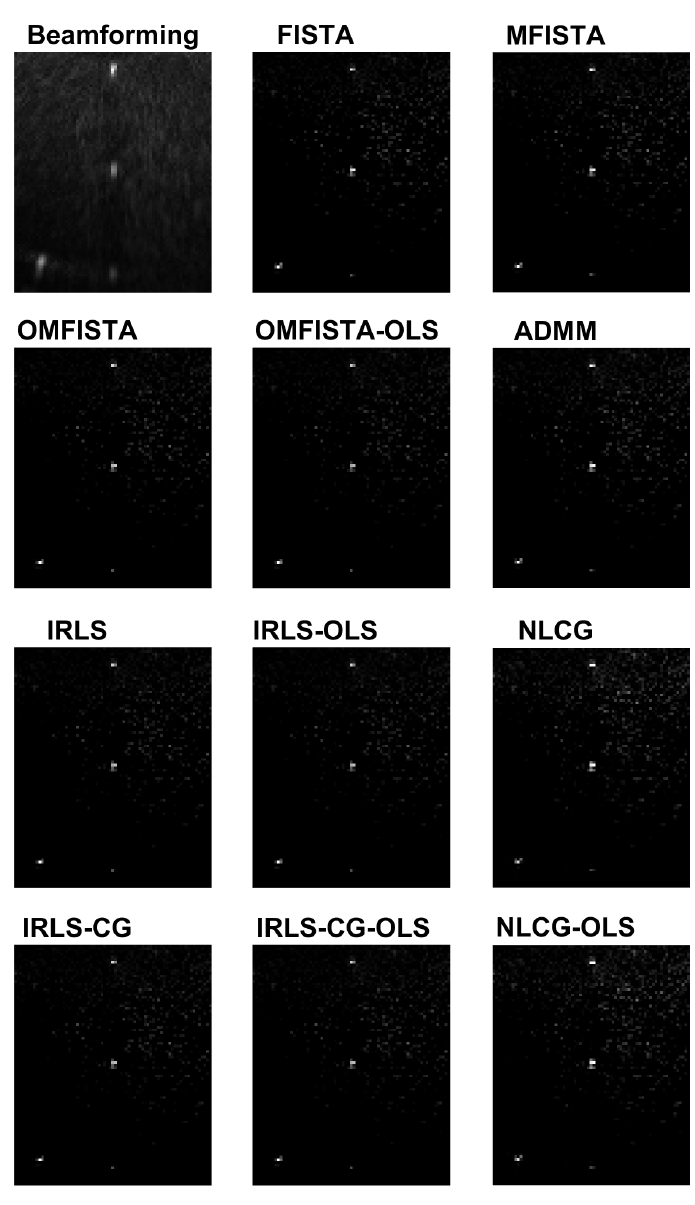
Figure 20. Reconstructed images from a distinct real dataset, of a different